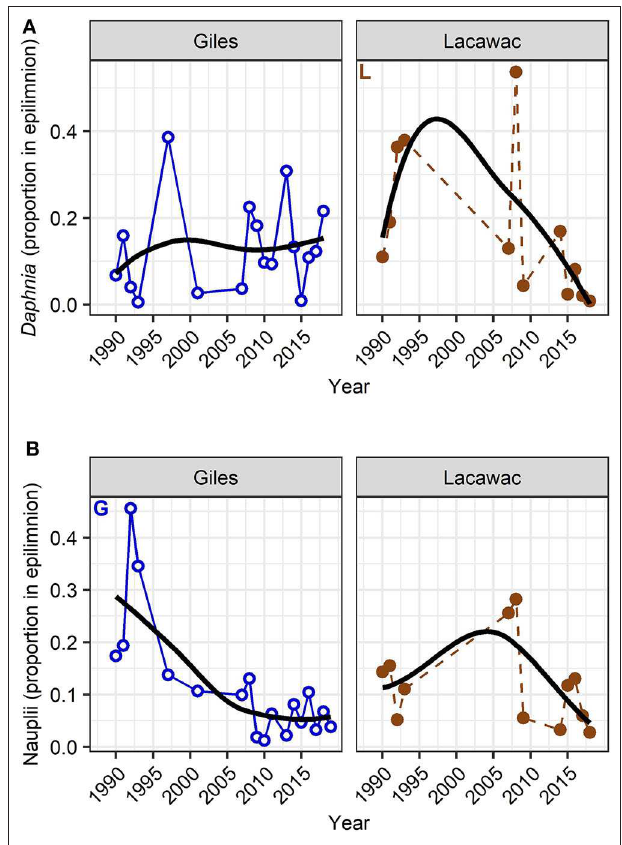
FIGURE 5 | Long-term summer average (June, July, August) changes in the vertical distribution (relative proportion in the epilimnion) of Daphnia (A) and copepod nauplii (B) in Lake Giles (blue, open circles with solid line), and Lake Lacawac (brown, filled circles with dashed line). Letters indicate statistically significant long-term trends in Giles (“G”) and in Lacawac (“L”; Mann-Kendall non-parametric trend test, p < 0.05). Black trend lines are LOESS smoothed